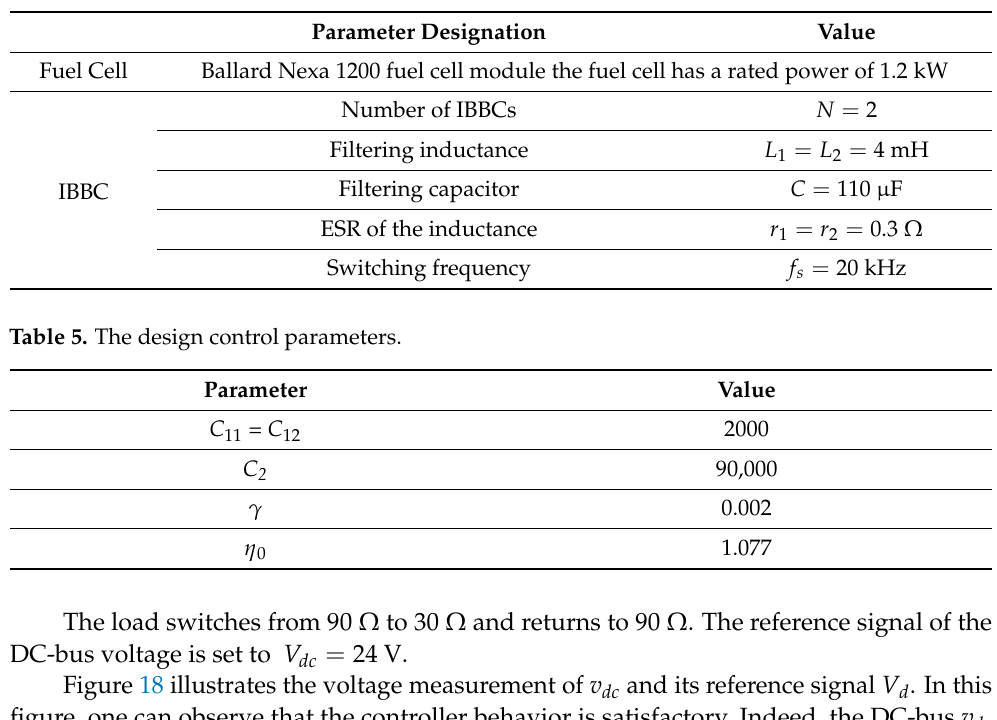
Table 4. Controlled system parameters.